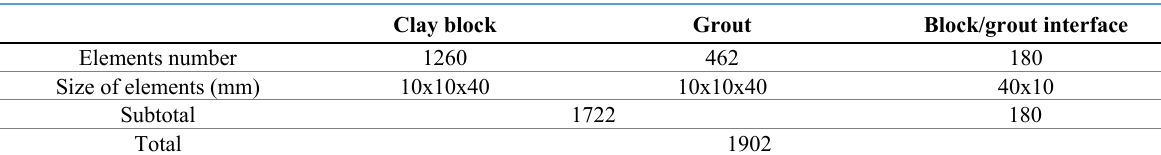
Table 5. Number and size elements of the push-out mesh.